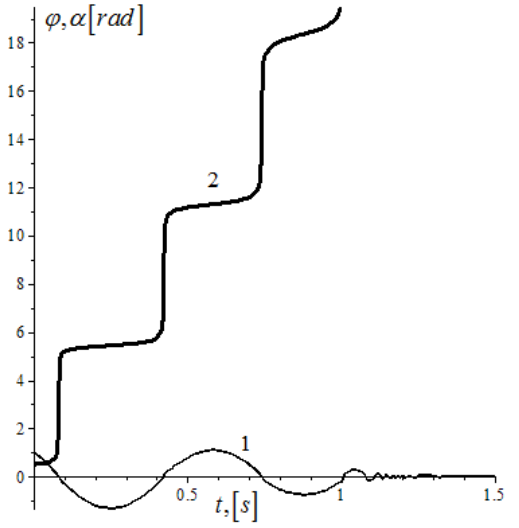
Figure 2. Line 1 shows the time law of the angle in azimuth α ( t ) ; Line 2 shows the time law of the polar bearing ϕ ( t ) . Initial conditions for this problem are α ( 0 ) = π parameters are k 2 = γ = 0.1 and ε = 0.02.